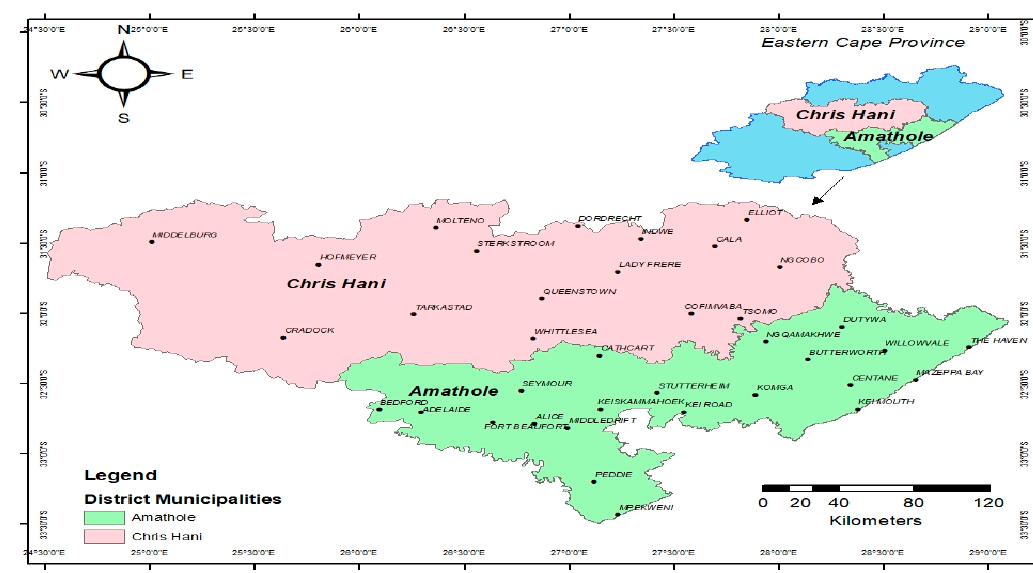
Figure 1. Map of Chris Hani and Amathole District Municipalities in the Eastern Cape Province, South Africa.